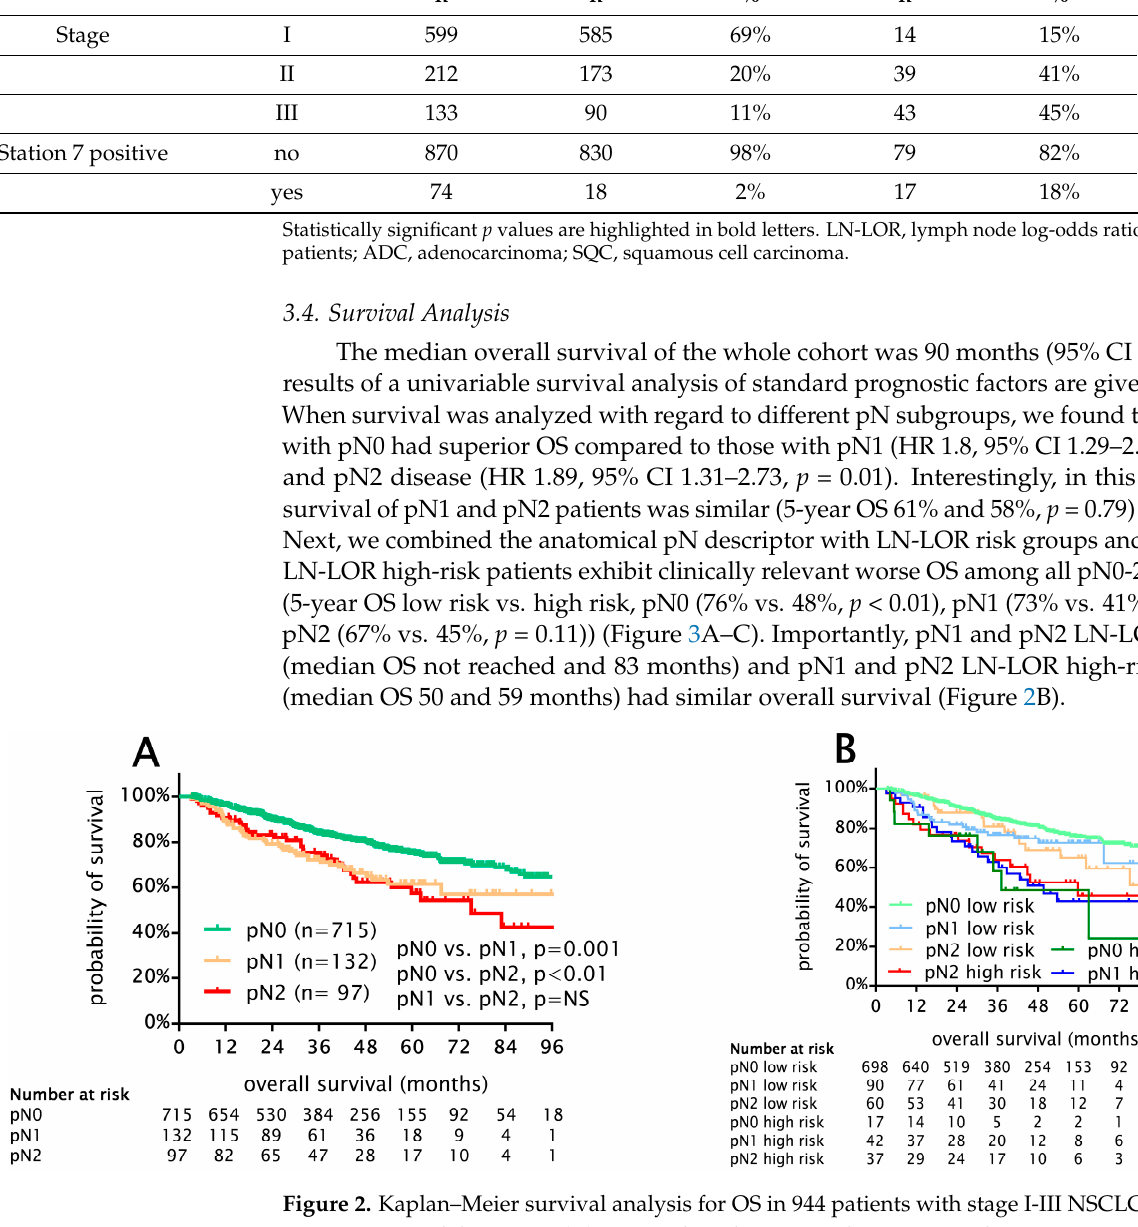
Table 2. Cont. All Patients